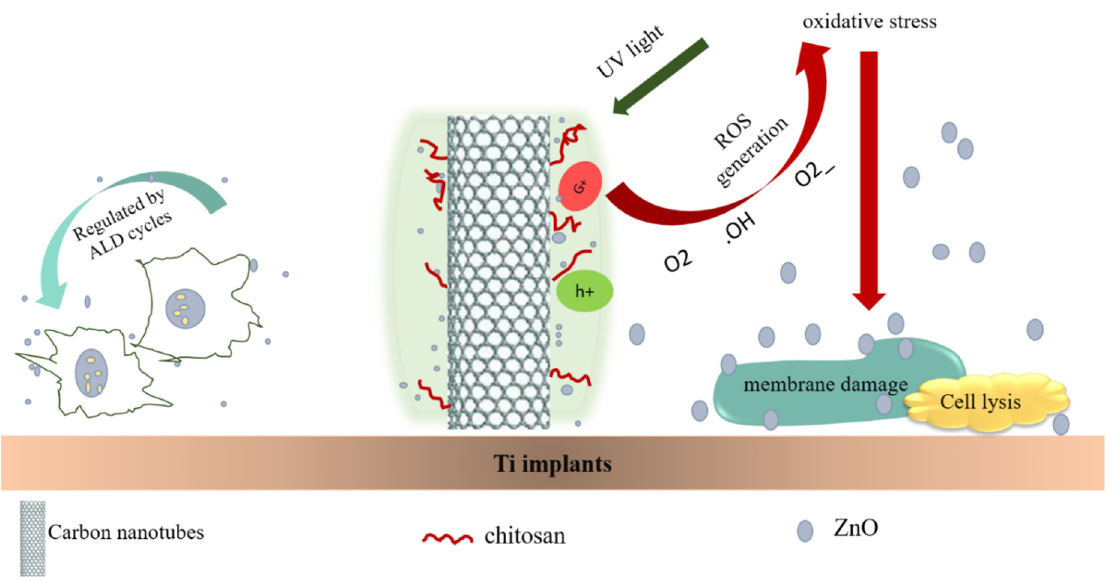
Figure 1. ZnO/chitosan/carbon nanotubes hybrid system biofunctionalization mechanism on Ti im-